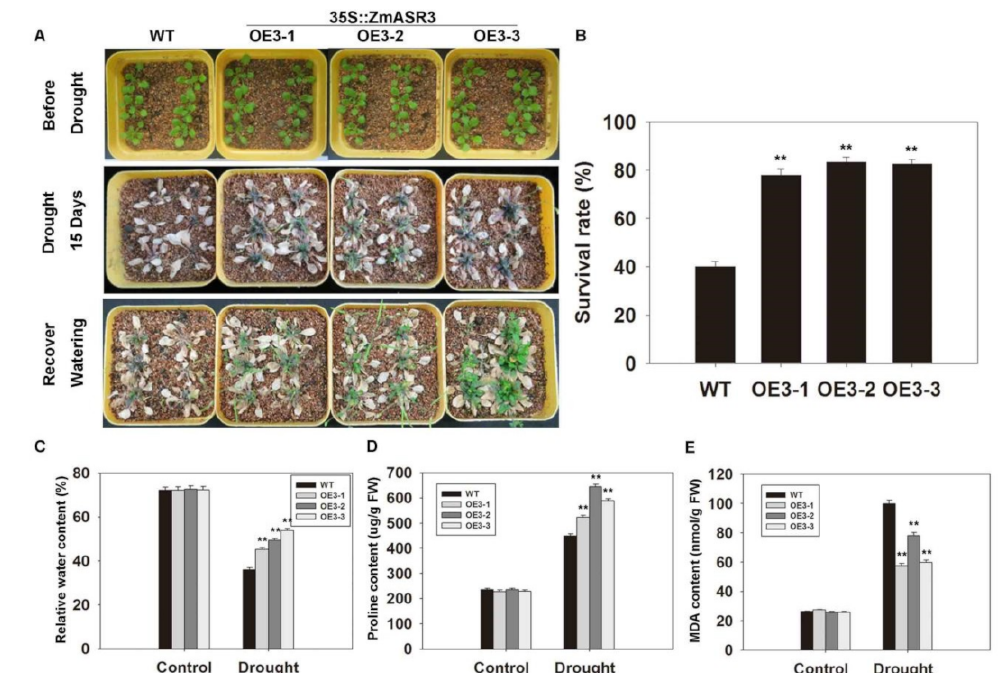
Figure 5. Overexpression of ZmASR3 enhances drought tolerance in Arabidopsis in soil. ( A ) Drought tolerance of three transgenic lines and wild-type plants. ( B ) Survival rate, ( C ) relative water content, ( D ) proline content, and ( E ) MDA content were subsequently measured. All samples were measured in three independent experiments (each with 50 seedlings for each line). In ( B – E ), vertical bars indicate means ± S.E. ( n ≥ 3). Significant di ff erences: ** p <